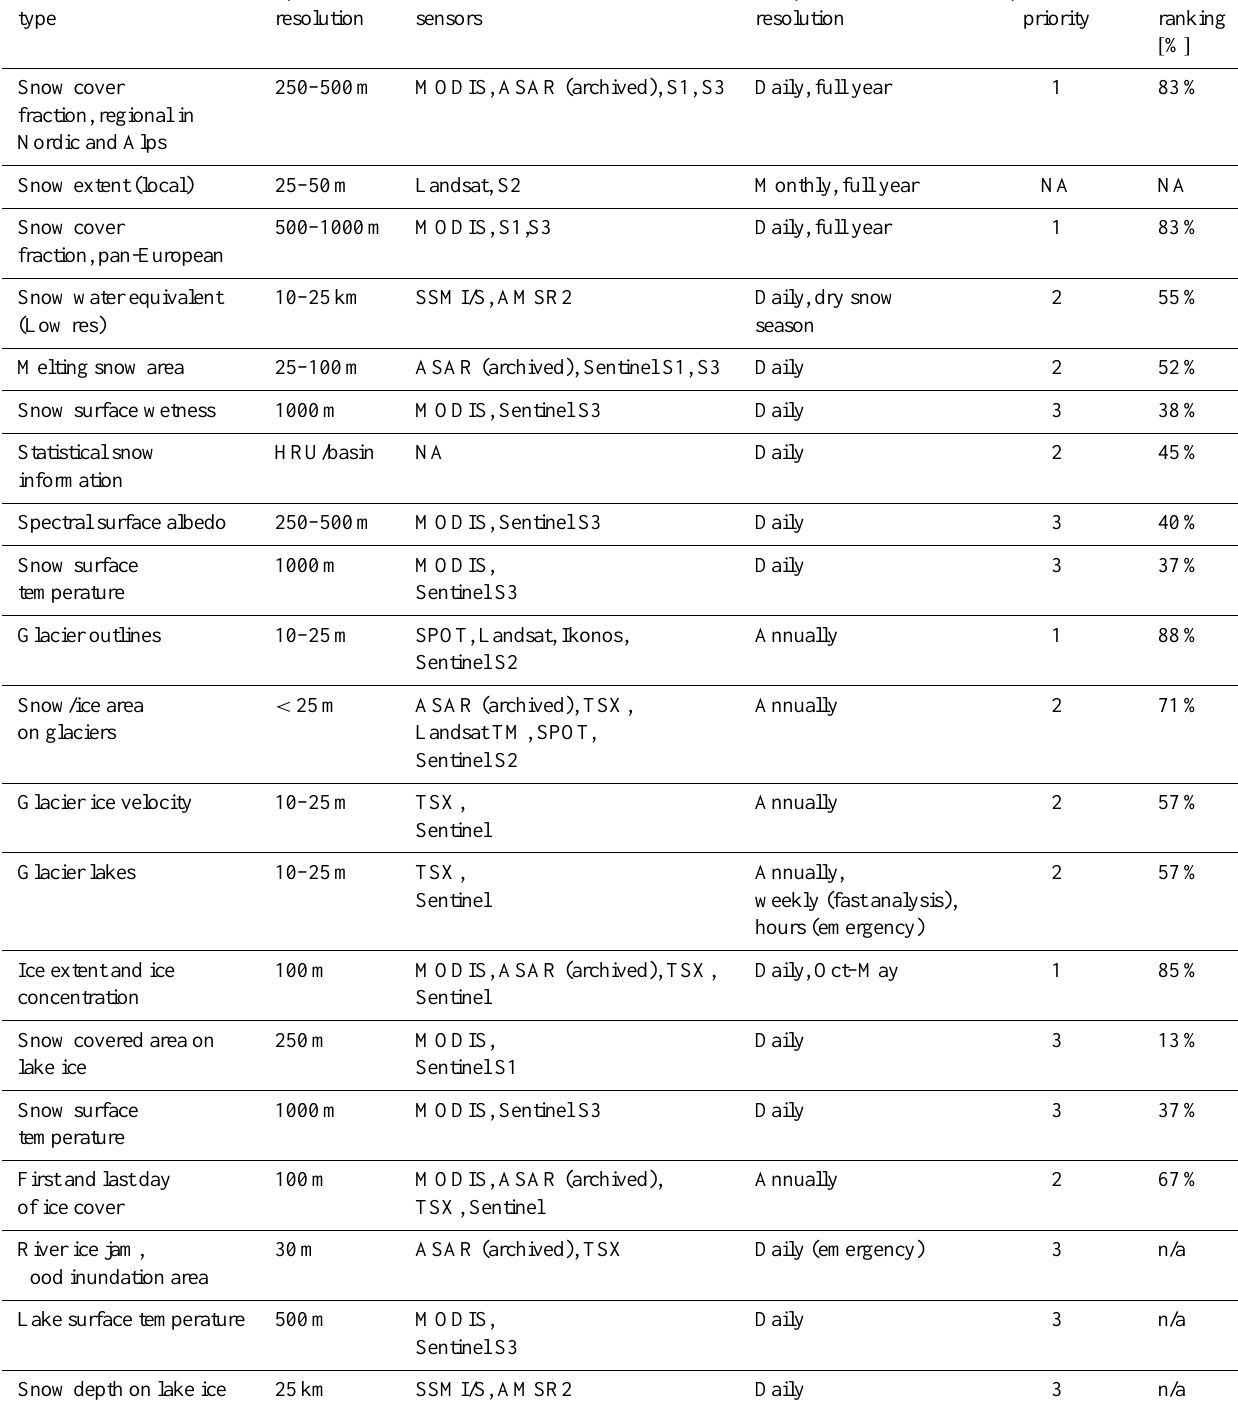
Table 3. Requirements for spatial and temporal resolution of products and product